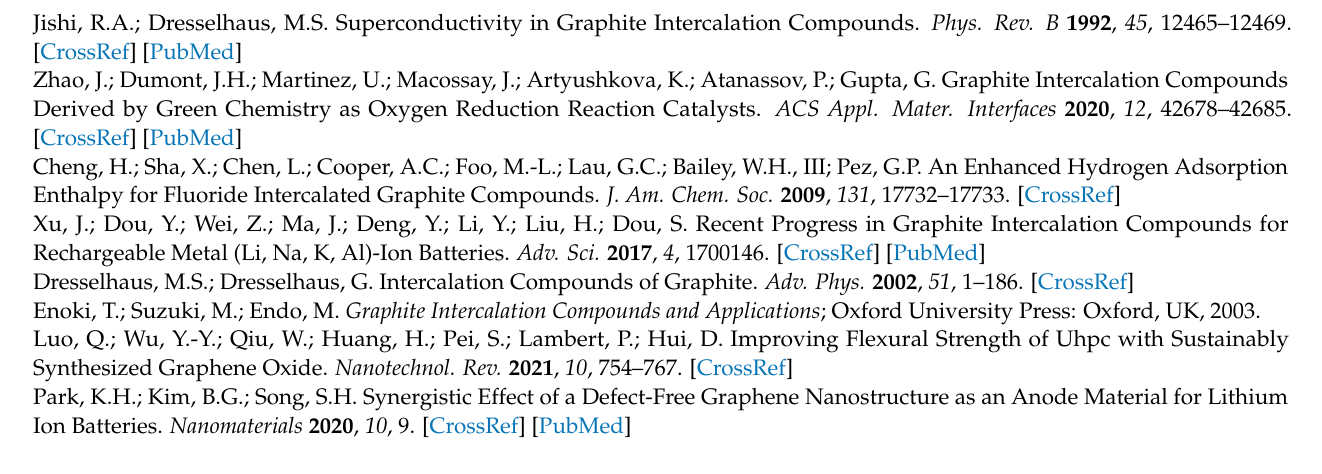
by molecule dy-namic with a simulated time of (a) 0 ns, (b) 5 ns and (c) 10 ns. Video S1: ANI cations gradually absorb on the surface of bilayer graphene (total 10 ns, every 20 ps per frame). Video S2: Few ANI cation achieves the intercalation(total 10 ns, every 20 ps per frame). Video S3: ANI cations successfully intercalate into the graphite with the assistance of ultrasonication (total 3 ps, every 10 fs per